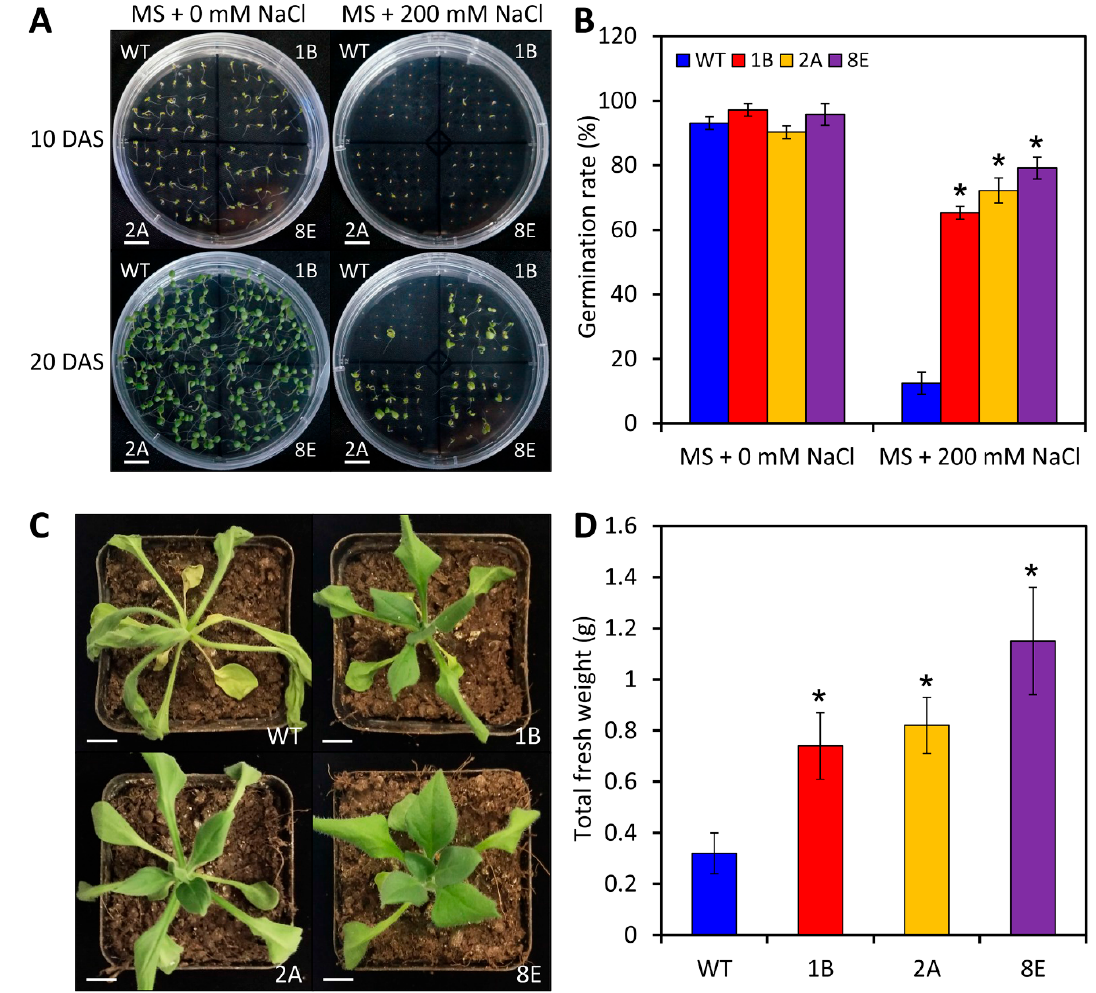
Figure 7. Enhanced tolerance to salt and drought stresses in transgenic petunia plants overexpressing LreEF1A4 . ( A ) Representative phenotypes of wild-type (WT) and transgenic petunia seedlings (1B, 2A, and 8E) grown in Murashige and Skoog (MS) media containing 0 and 200 mM NaCl. Photographs were taken at 10 and 20 days after sowing (DAS). Scale bars = 1.0 cm. ( B ) Germination percentage of WT and transgenic seedlings at 20 DAS. Representative phenotypes ( C ) and total fresh weight ( D ) of WT and transgenic petunia seedlings at 5 days post treatment with dehydration. Five-week-old plantlets were used for the treatment. Scale bars = 1.0 cm. Error bars represent standard error (SE) of the mean from three independent biological replicates. Asterisks denote statistical significance as determined by Student’s t -test ( p <